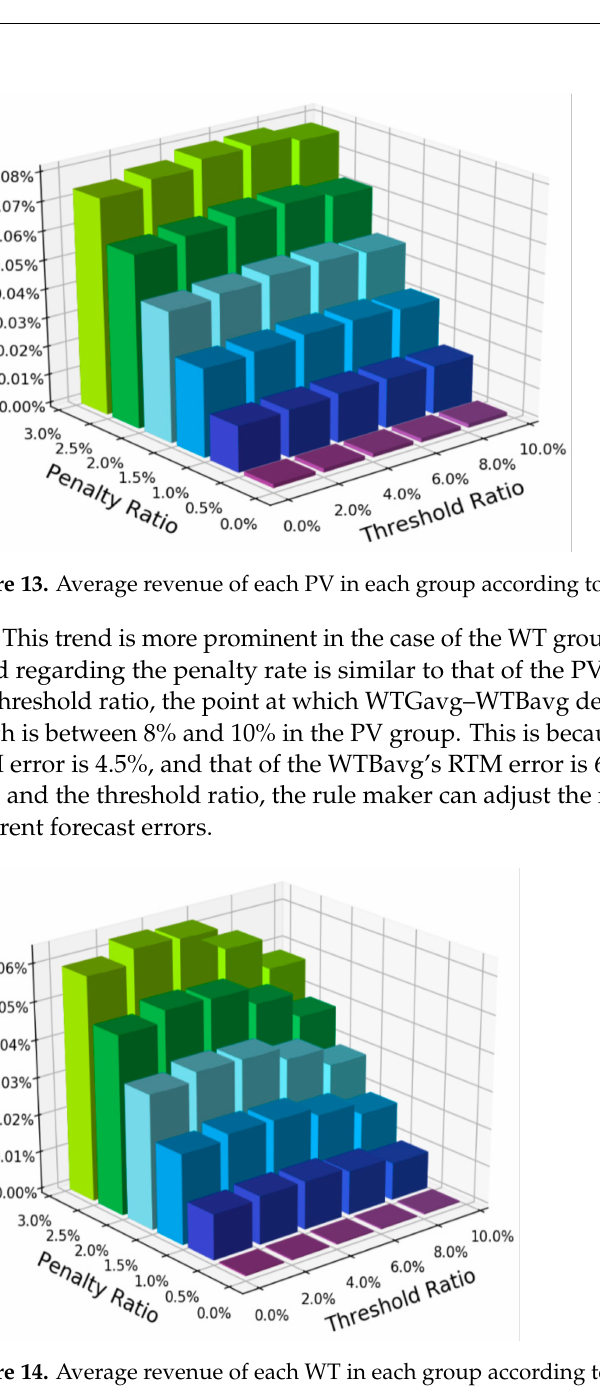
Figure 14. Average revenue of each WT in each group according to imbalance pricing